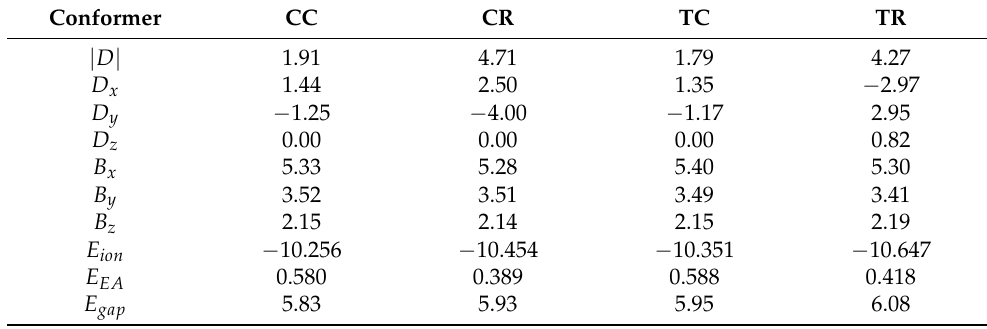
Table 2. Molecular parameters of the four conformers. Dipole moments ( D ) and its components ( D x , D y and D z ) are given in Debye, rotational constants ( B x , B y and B z ) in GHz and the ionization threshold ( E ion ), the electron affinity ( E EA ) and the gap energy ( E gap ) in eV.